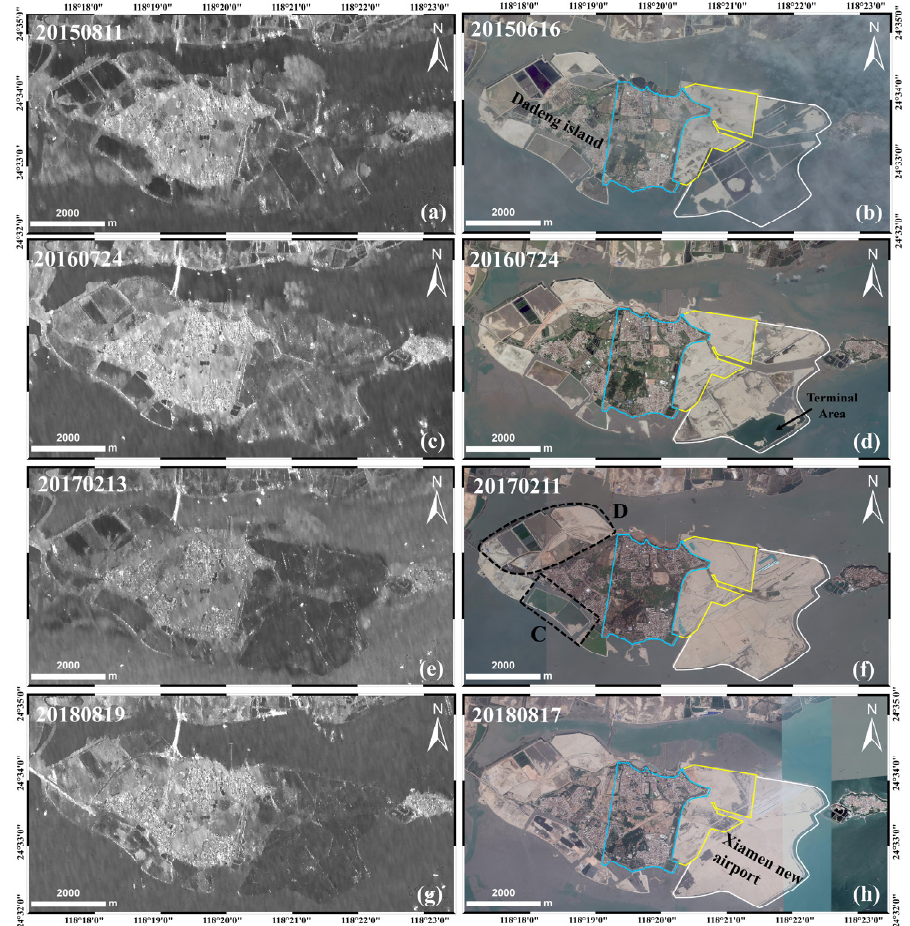
Figure 5. Four SAR intensity images and four remote sensing images of Xiamen New Airport. Intensity images were acquired on ( a ) 11 August 2015, ( c ) 24 July 2016, ( e ) 13 February 2017, and ( g ) 19 August 2018, respectively; remote sensing images were acquired on ( b ) 16 June 2015, ( d ) 24 July 2016, ( f ) 11 February 2017, and ( h ) 17 August 2018, respectively. Solid blue line represents the pre-existing land area of Xiamen New Airport, solid yellow line indicates the area of the first phase of land reclamation, and solid white line indicates the one in the second